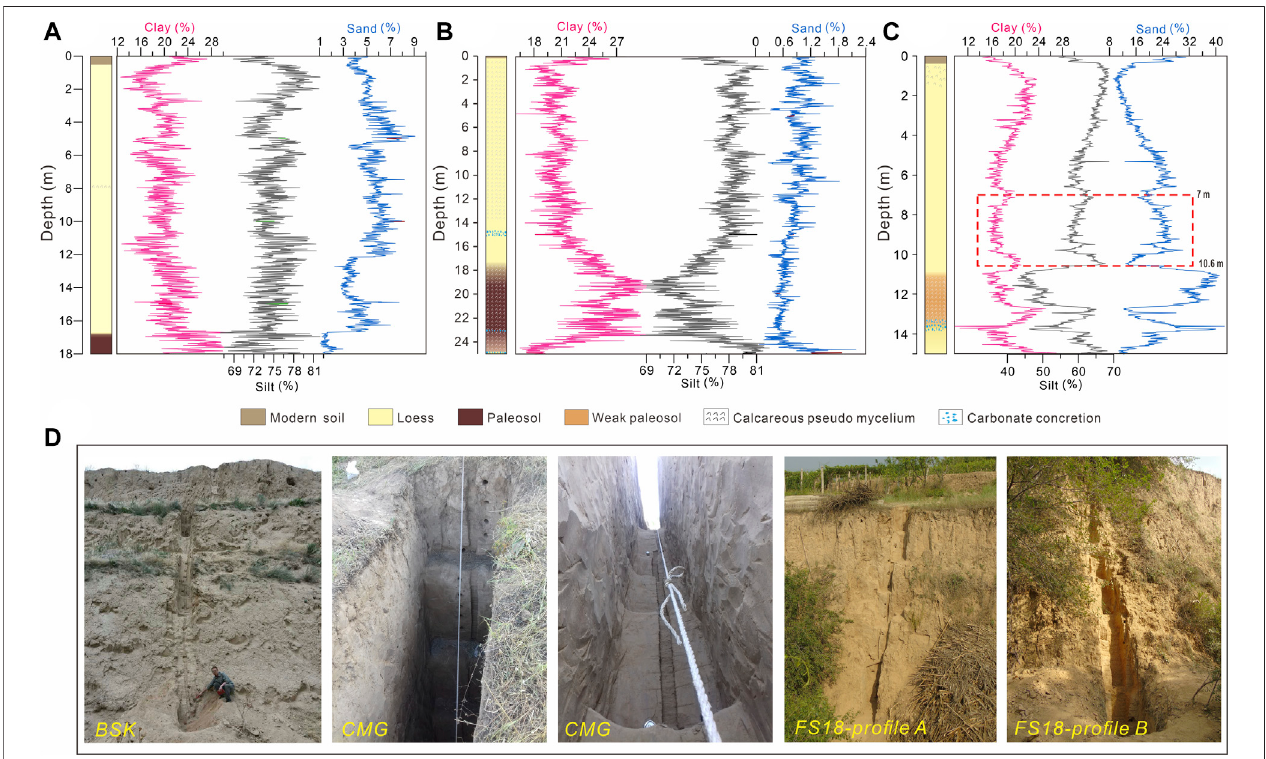
FIGURE 3 | Stratigraphic logs (A – C) , grain size results (A – C) and photos (D) of the BSK, CMG and FS18 loess sections. The red dashed box in (C) indicates the depth interval [7 – 10.6 m in FS18-subsection (B) ] that is not used for the analyses due to its chronological overlap with the upper 7 m ( Supplementary Material ).